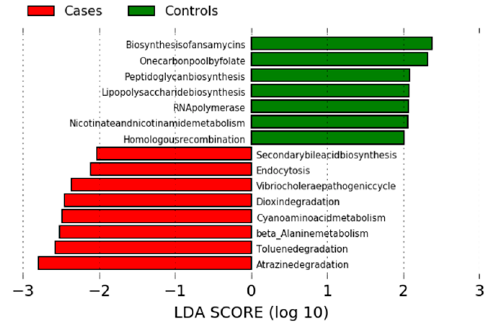
Figure 5. Comparison of microbial functional pathways between cases and controls.